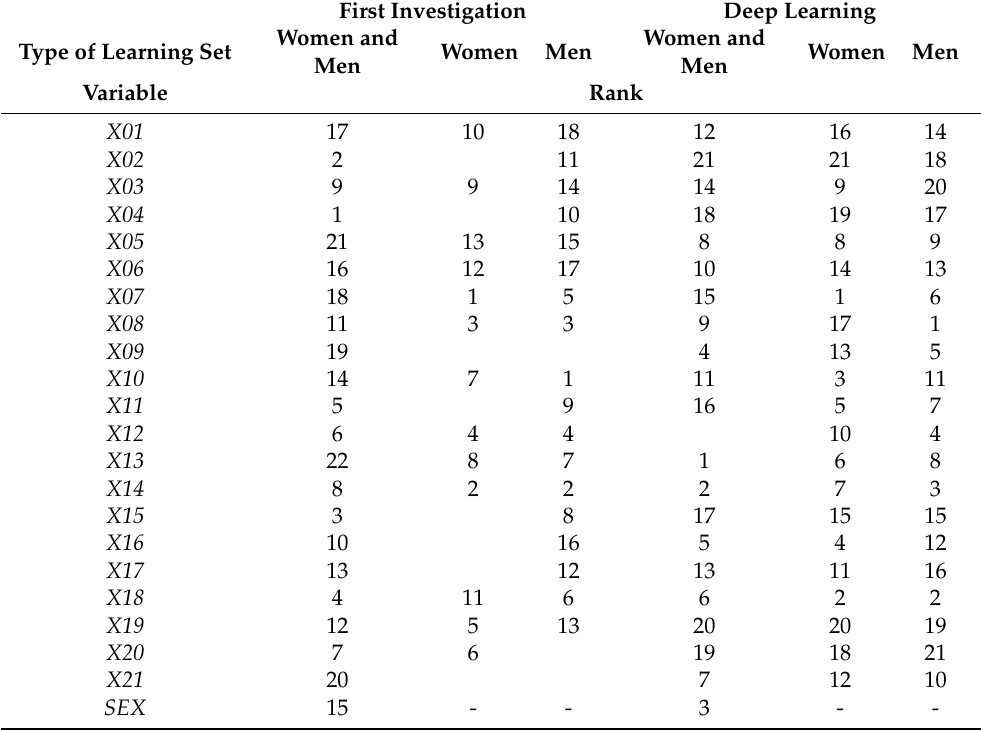
Table 8. Comparison of sensitivity analysis of variables from the first phase of the study and the current